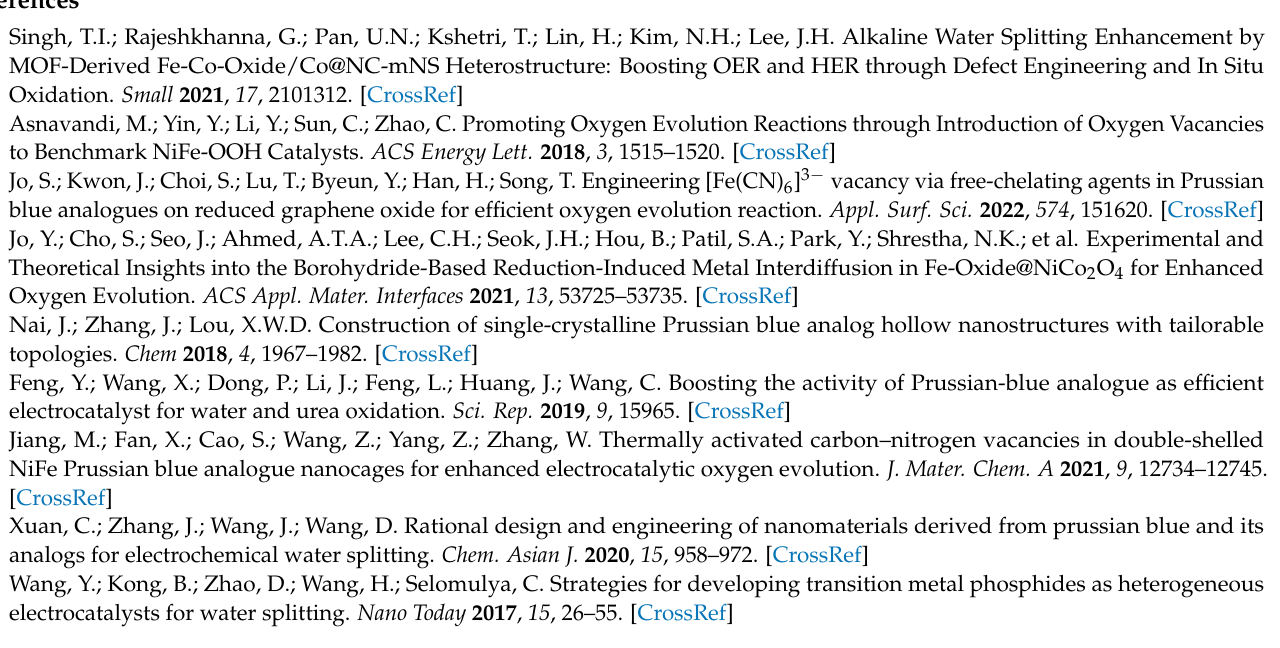
24 h OER test. Figure S6. FT-IR spectra of NiFe PBA and D-NiFe PBA before and after 24 h OER test. Figure S7. XRD spectra of NiFe PBA and D-NiFe PBA after 24 h OER test. Figure S8. EDX spectra of NiFe PBA and D-NiFe PBA before and after 24 h OER test. Table S1. The atomic ratio obtained